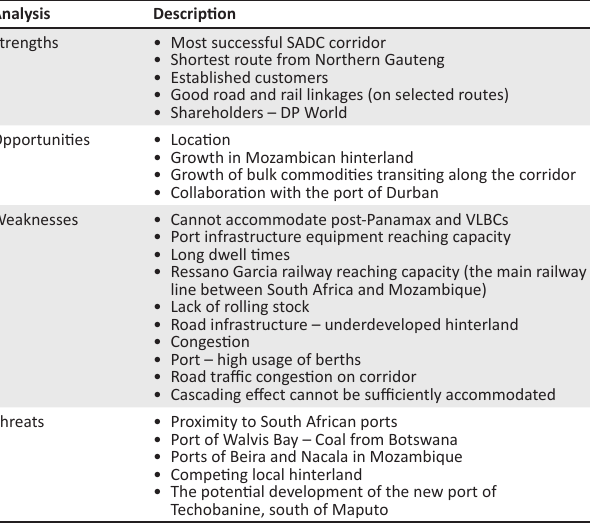
TABLE 4: Strengths, weaknesses, opportunities and threats analysis of Maputo port. Analysis Description